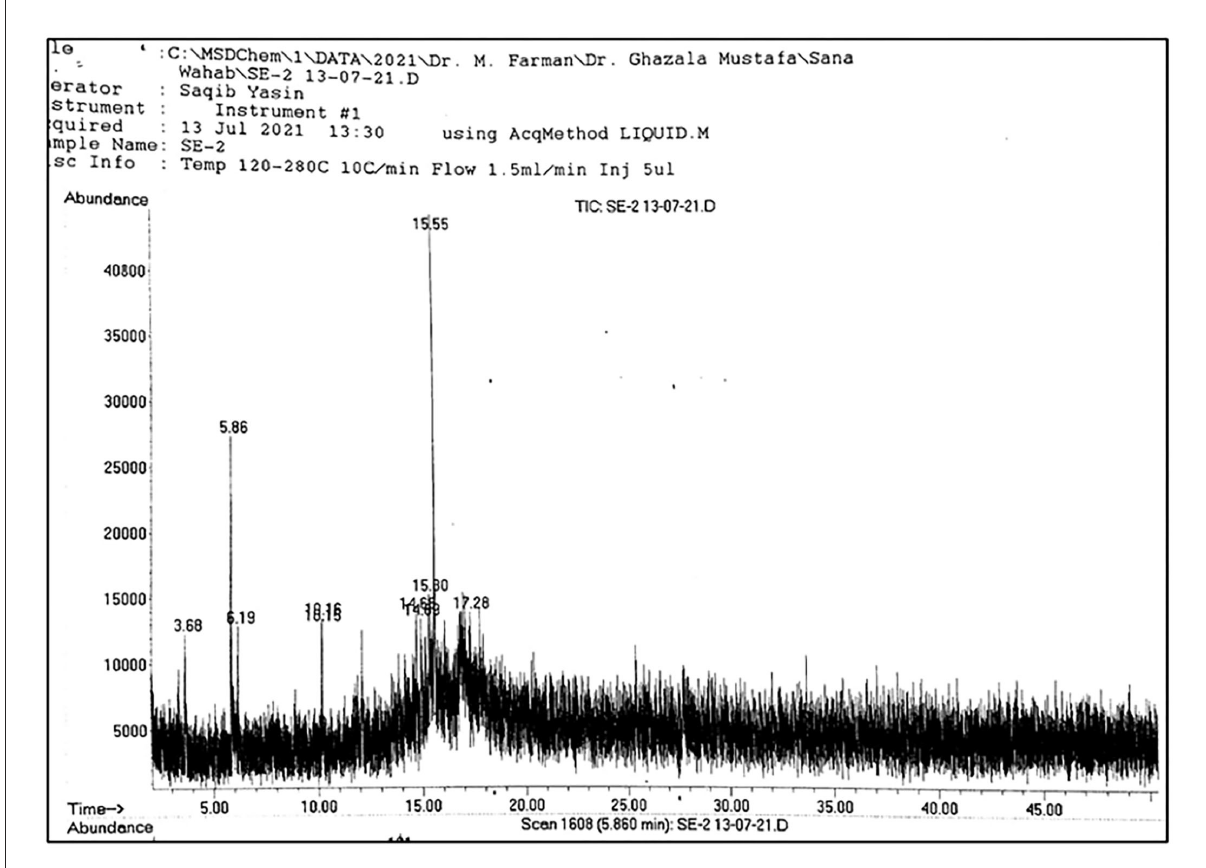
FIGURE2 Spectrum obtained through GC-MS of pulp